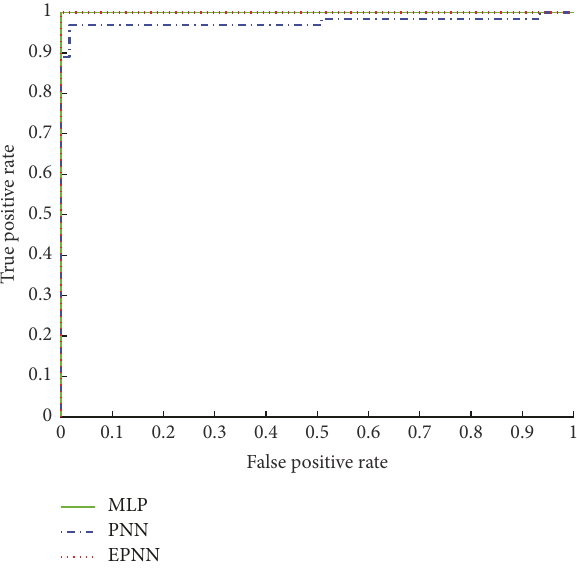
Figure 5: The ROC of the Qualitative Bankruptcy data